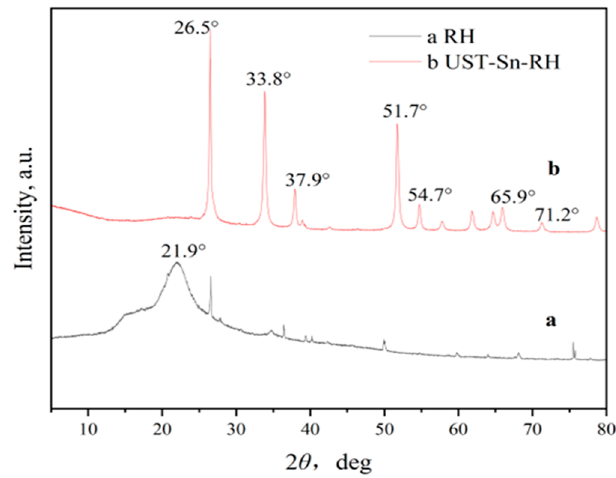
Figure 4. X-Ray Diffraction (XRD) images of RH and chemocatalyst UST-Sn-RH [XRD was carried out by using a D/max-2500 (Japan) instrument (Rigaku Co., Akishima-shi, Japan) with CuK α radiation ( λ = 1.5406) (40 kV, 30 mA). The 2 θ angle was scanned between 5° and 80°.